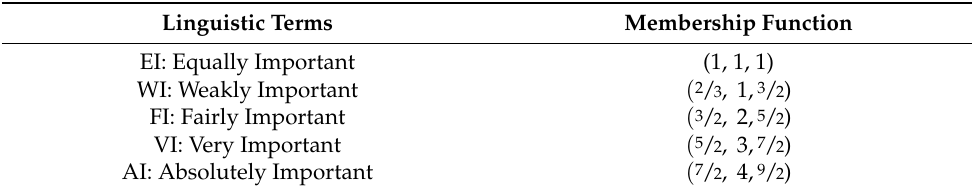
Table 3. Linguistic